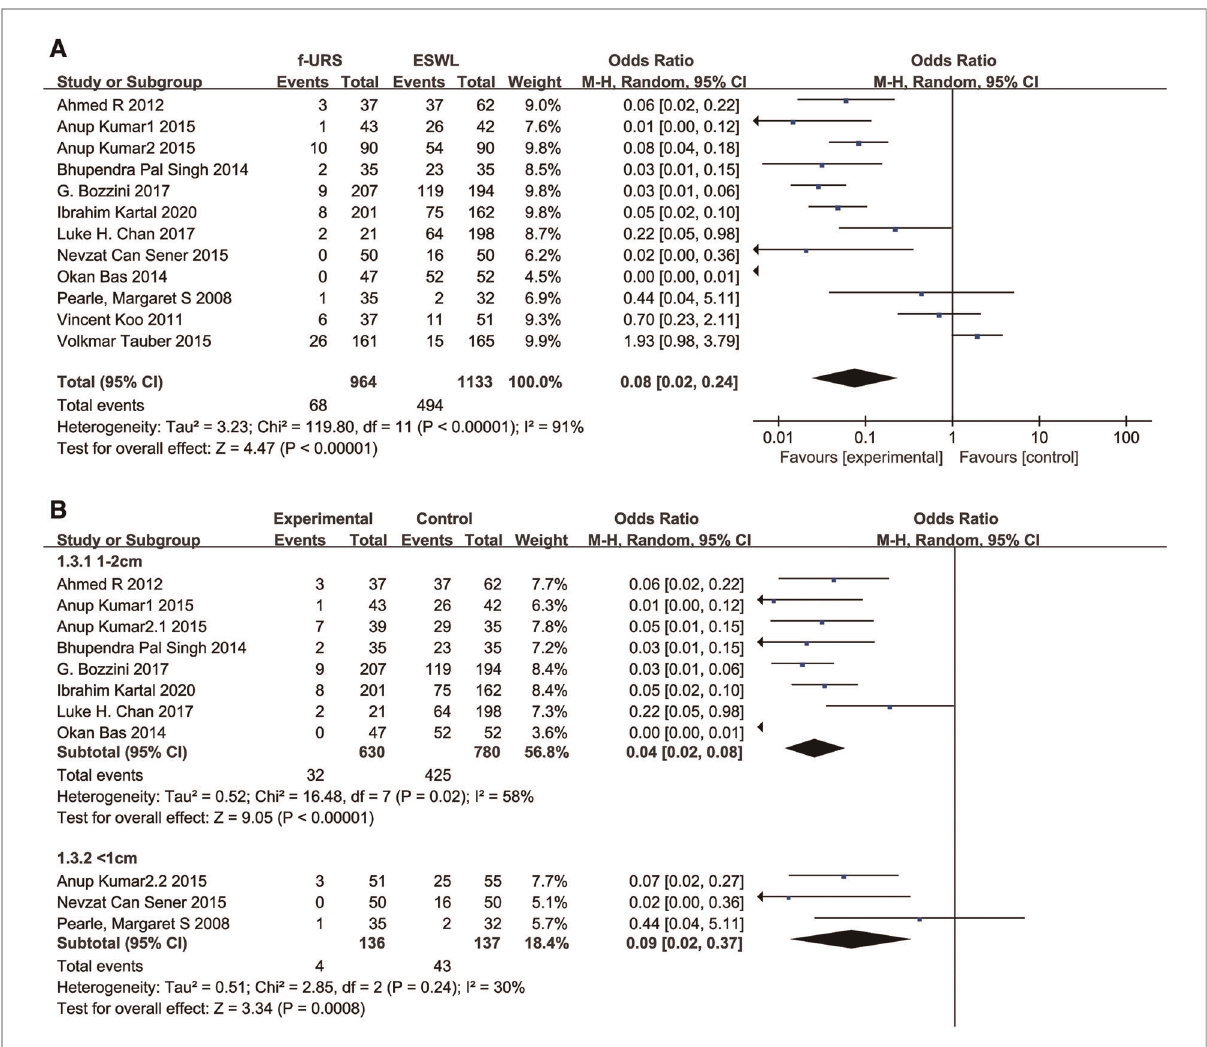
FIGURE 6 Forest plot and meta-analysis of retreatment rate for ( A ) all studies and ( B ) subgroups of stone length 1 – 2 cm and <1 cm for f-URS and